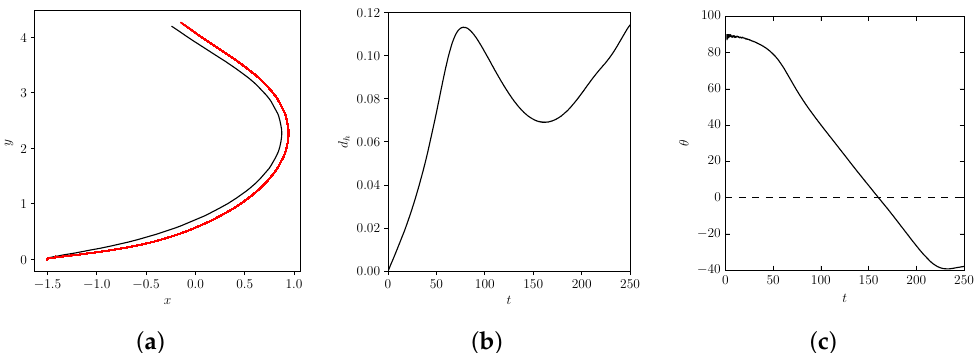
− 1 . 5 − 1 . 0 − 0 . 5 0 . 0